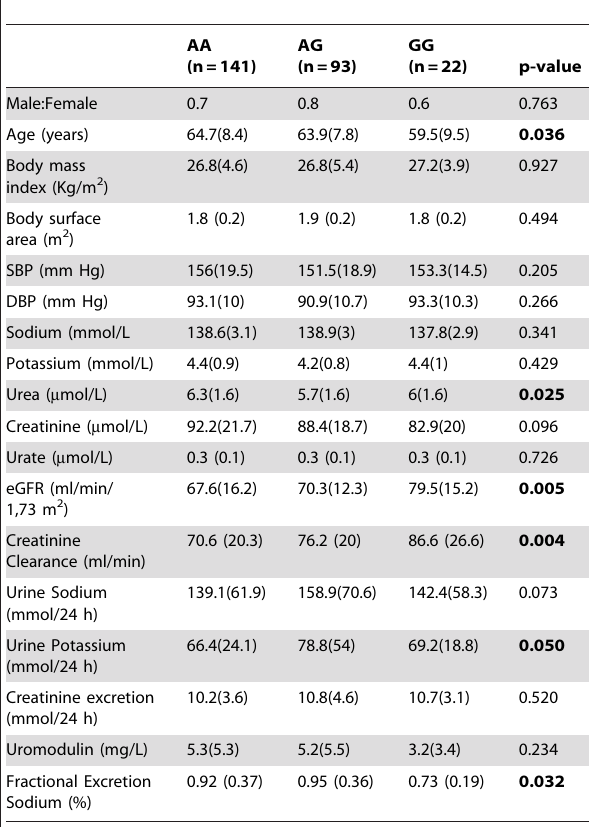
Table 5. Univariate association analysis of rs13333226 in 110 participants from the HERCULES Study.